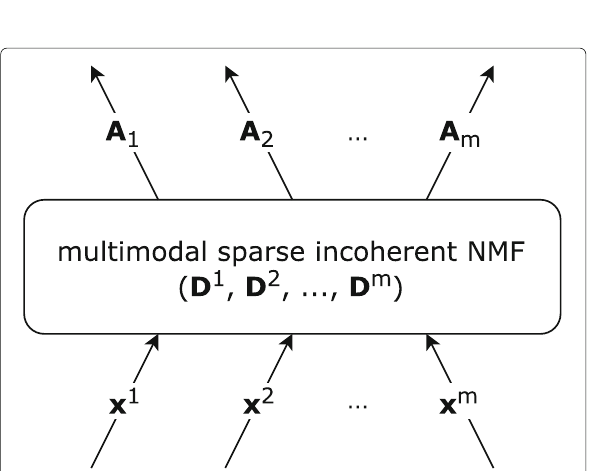
Fig. 4 Structure of MSI-NMF layer. Legends can be referred to Fig. 1. Following Caffe terminology, arrows indicate tensors (Caffe blobs), and dictionaries ( D i , i = N m ) are treated as layer parameters